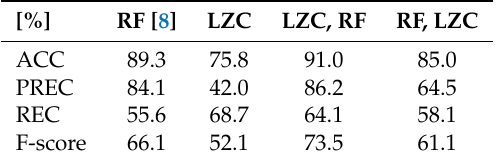
Table 4. Performance evaluation of all applied variations of classification